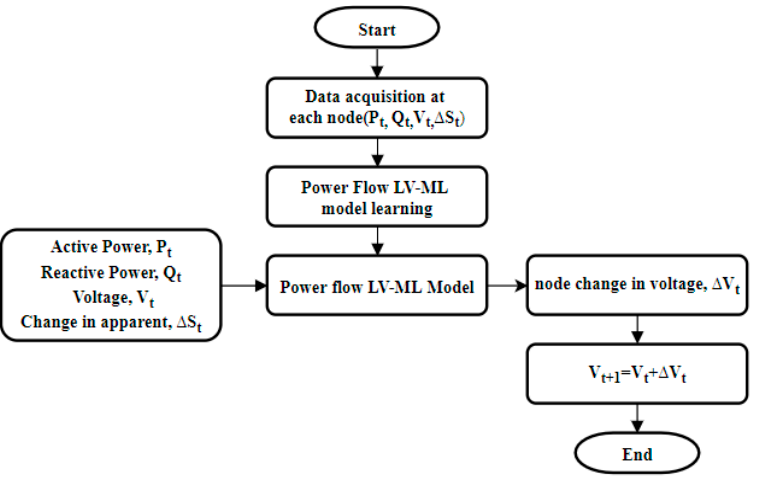
Figure 5. Flow chart of LV-ML Model .